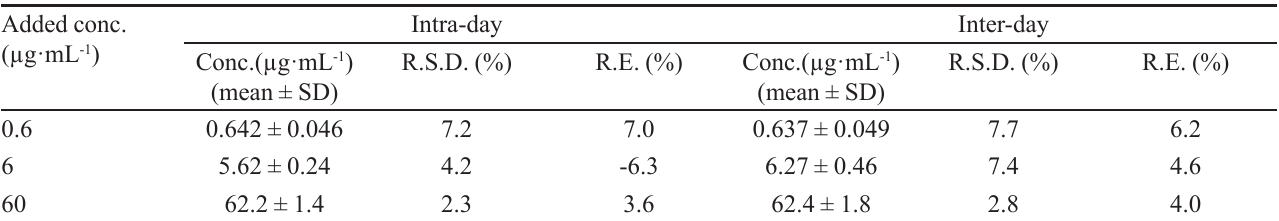
TABLE I - Precision and accuracy of isoquercitrin determination in rat plasma (intra-day: n = 5; inter-day: n = 3 days with 5 replicates per day) Added conc.